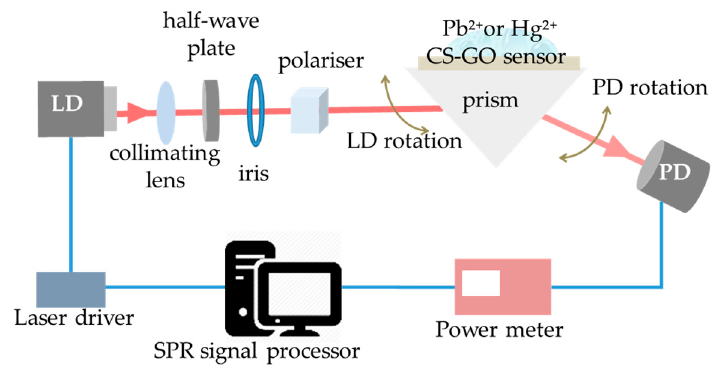
Figure 3. SPR spectroscopy based on the Kretschmann configuration.